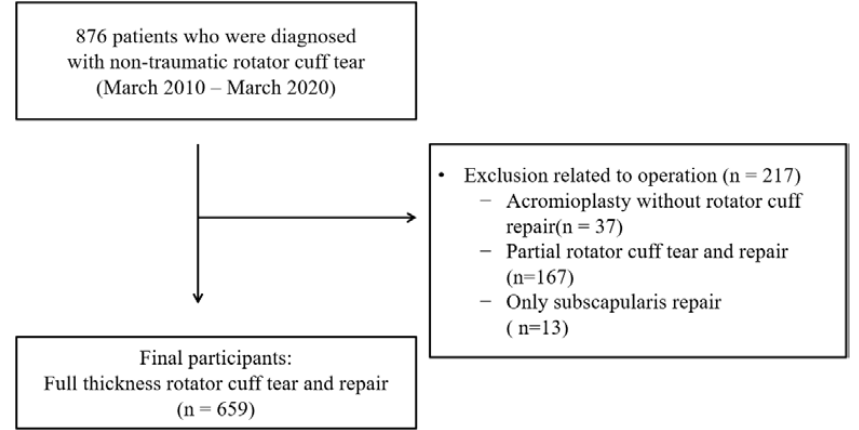
Figure 1. Diagram of the